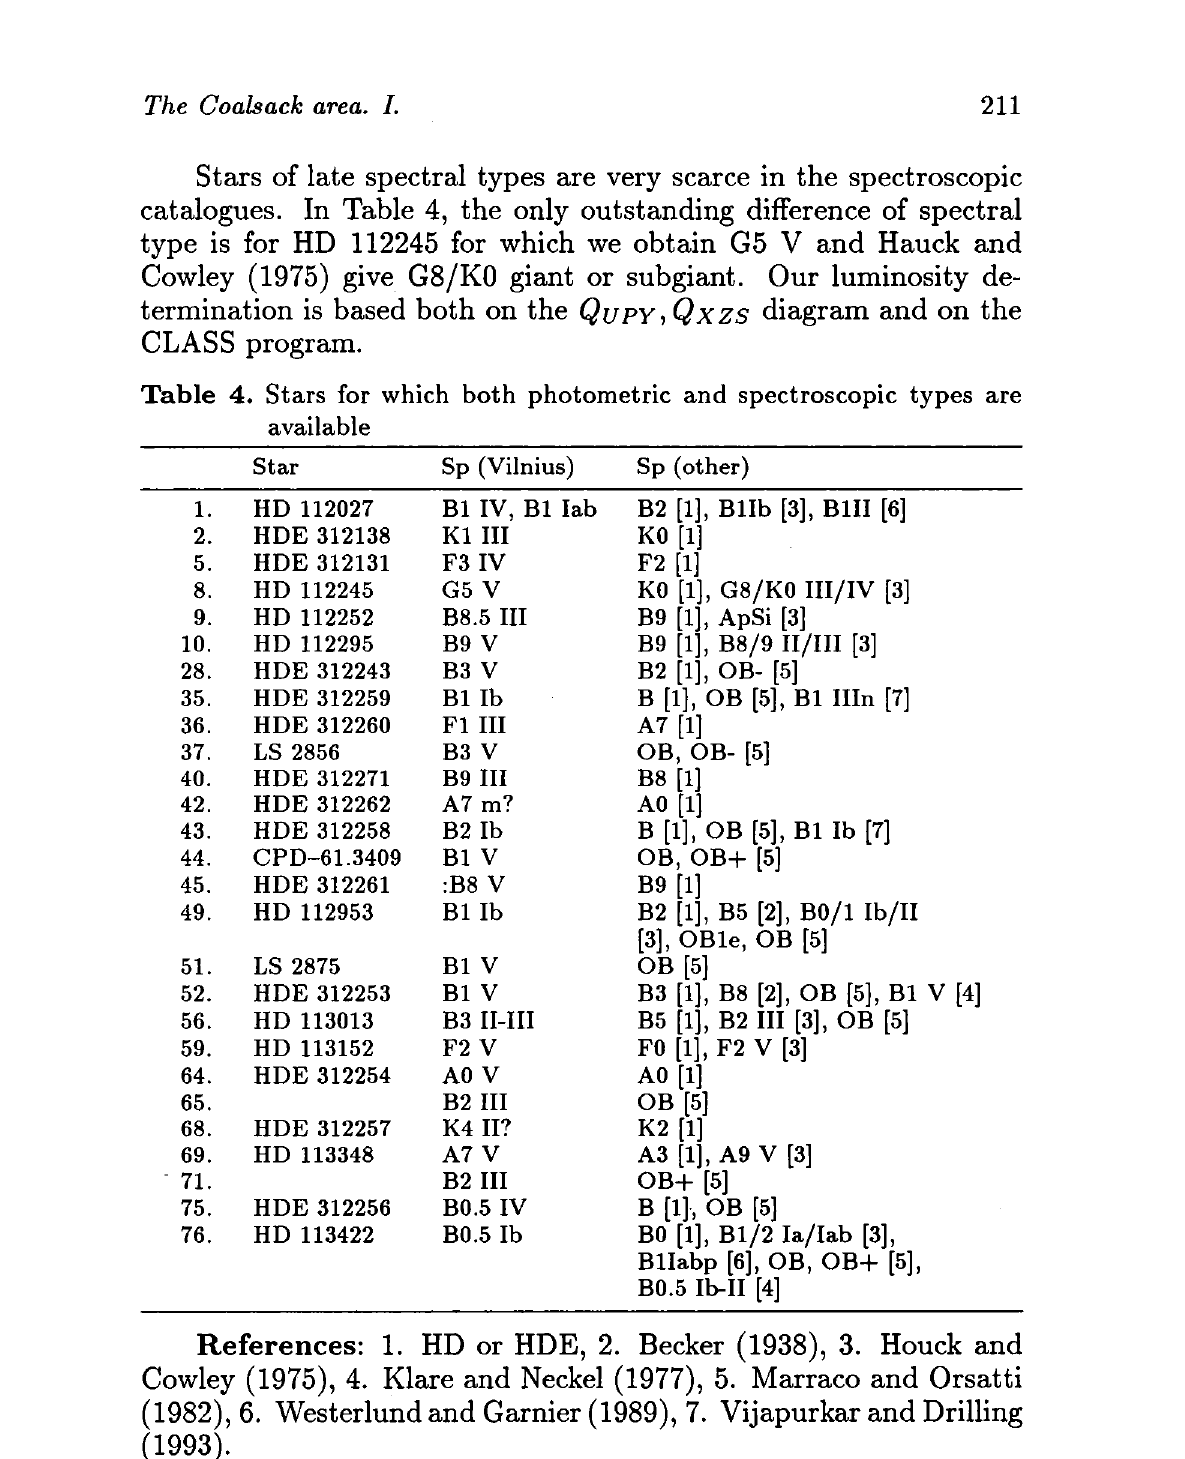
Table 4. Stars for which both photometric and spectroscopic types are